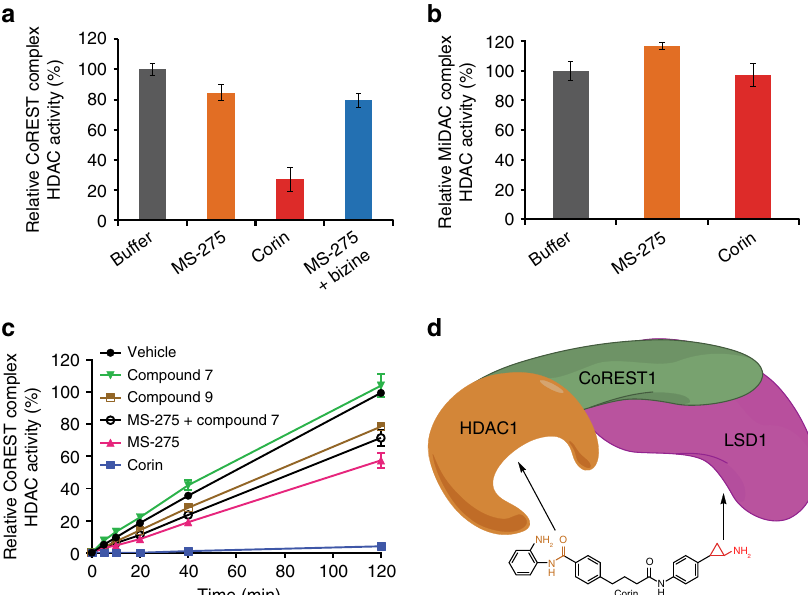
Fig. 3 Corin exhibits sustained inhibition of CoREST complex HDAC activity. a Relative CoREST complex HDAC activity. b Relative MiDAC complex HDAC activity. Protein complexes at 500 nM and all compounds at 5 µ M preincubated for 30 min prior to dialysis and dilution to measure HDAC activity at 2 nM (CoREST complex) or 8 nM (MiDAC complex). 50 µ M acetylated P53 379 – 382 tetrapeptide (RHKK(Ac)) was used as substrate. c Corin exhibits near irreversible inhibition of CoREST complex HDAC activity relative to unifunctional LSD1 and HDAC inhibitors after jump dilution (CoREST complex = 0.5 µ M, inhibitor = 5 µ M, substrate = 200 µ M acetylated P53 379 – 382 tetrapeptide RHKK(Ac)). d Model depicting dual engagement mechanism of corin leading to sustained inhibition of CoREST complex HDAC activity. Data (mean ± SEM) are representative of at least two independent